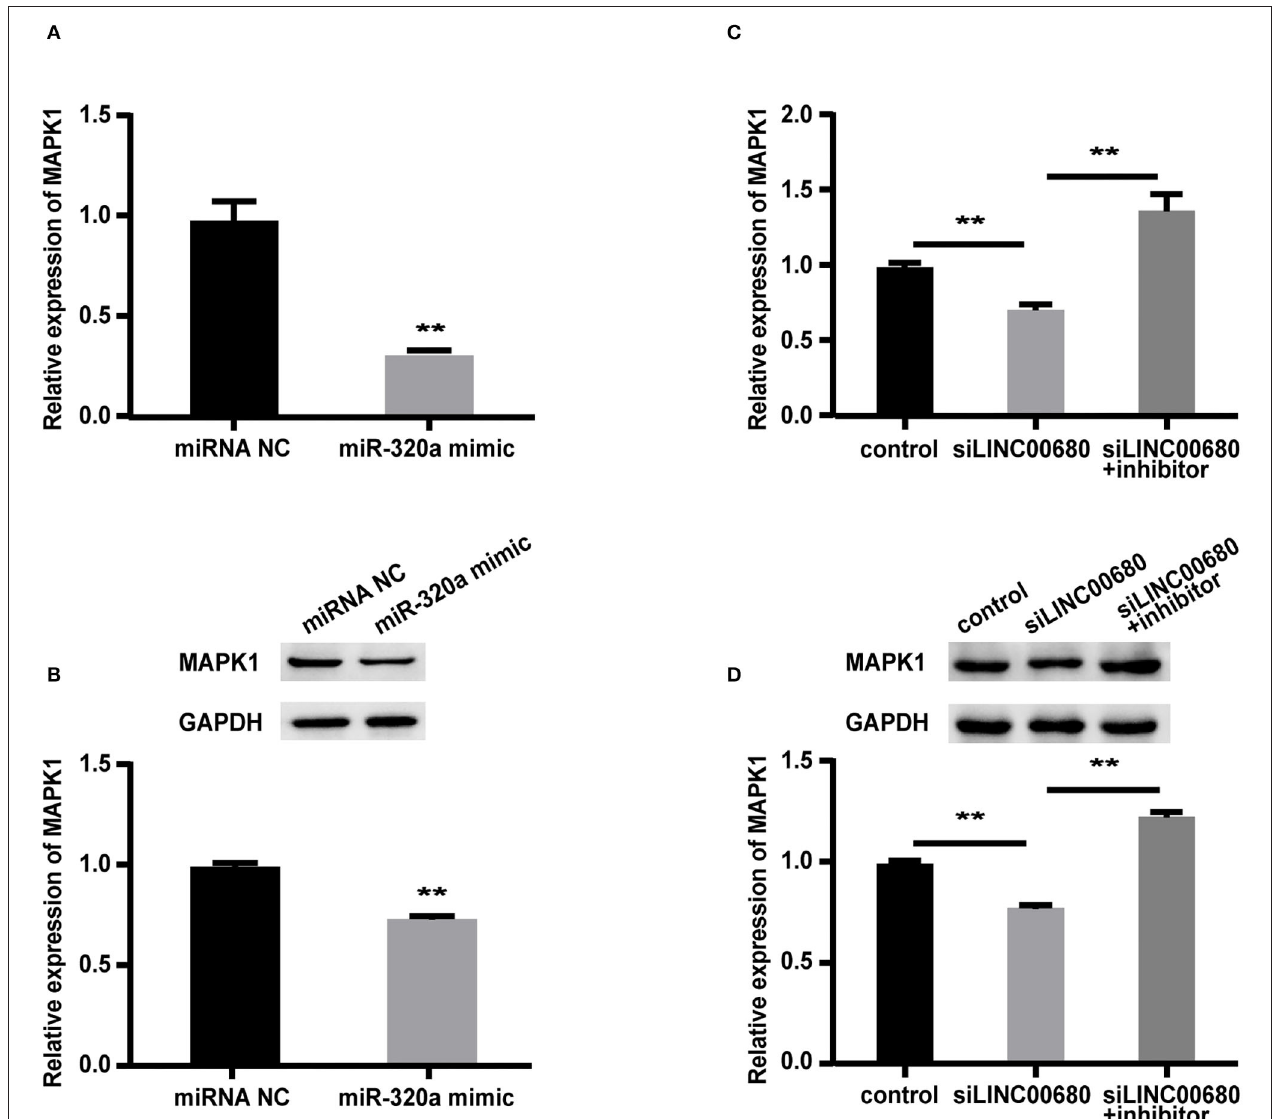
FIGURE 4 | LINC00680 regulated MAPK1 expression by binding miR-320a as a competing endogenous RNA (ceRNA). (A) The relative mRNA levels of MAPK1 were determined by real-time PCR after transfection with negative control or miR-320a mimic in Jurkat cells for 48h (B) Relative protein expression levels of MAPK1 were determined by Western blotting after transfection with negative control or miR-320a mimic in Jurkat cells for 48h (C) Relative mRNA levels of MAPK1 were determined by real-time PCR analysis after transfection with negative control, siLINC00680, and siLINC00680 + miR-320a inhibitor in Jurkat cells for 48h (D) Relative protein expression levels of MAPK1 were determined by Western blotting after transfection with negative control, siLINC00680, and siLINC00680 + miR-320a inhibitor in Jurkat cells for 48h (** p <